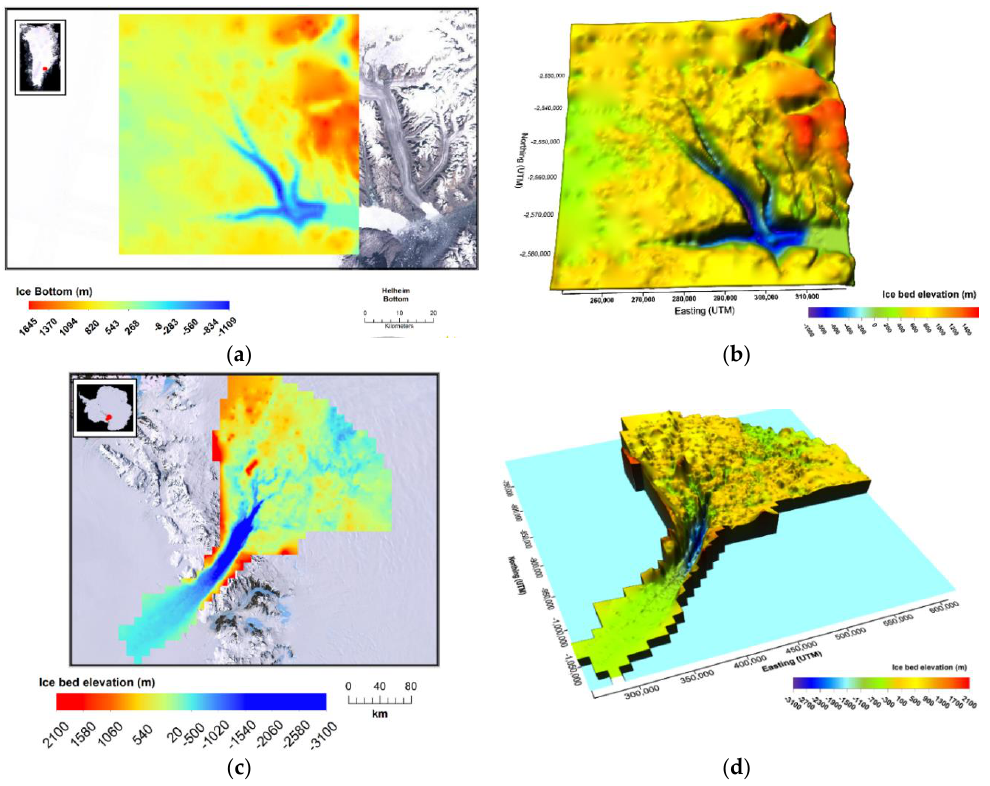
Figure 12. Ice-bed elevation maps of the Helheim Glacier in ( a ) 2-D and ( b ) 3-D; Ice-bed elevation maps of the Byrd Glacier in ( c ) 2-D and ( d ) 3-D.